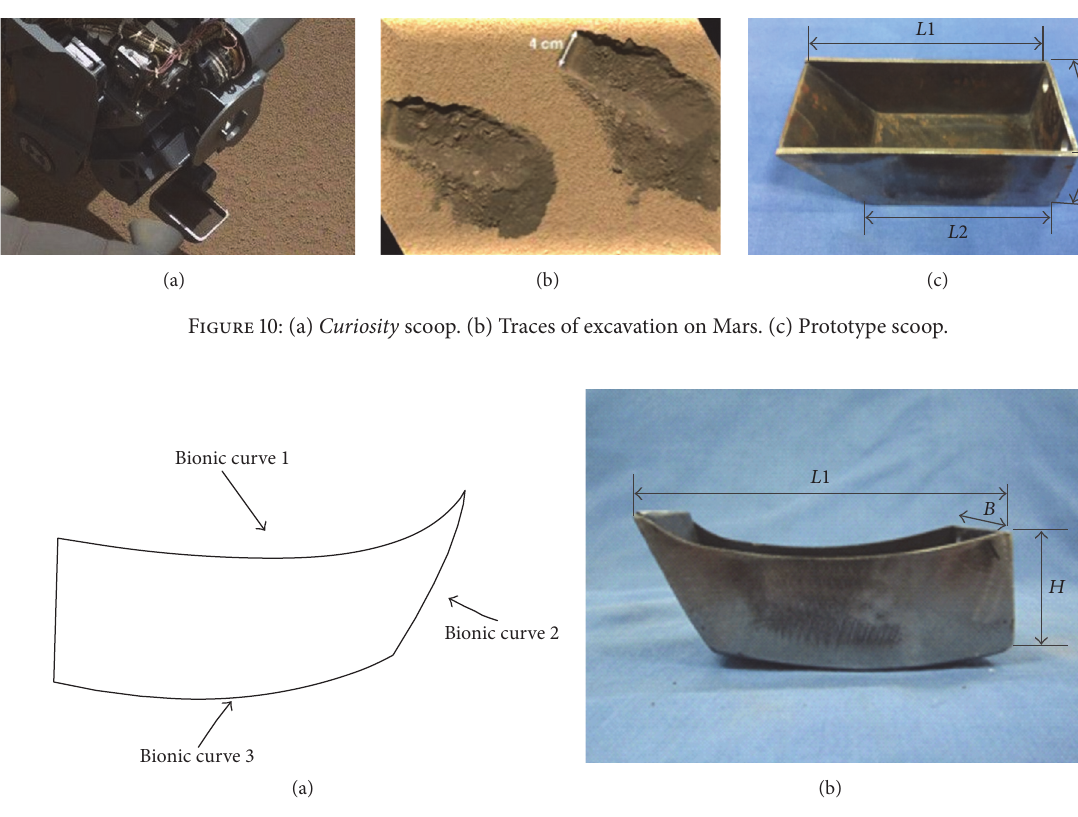
Internal fitting curve 5 was selected as bionic curve